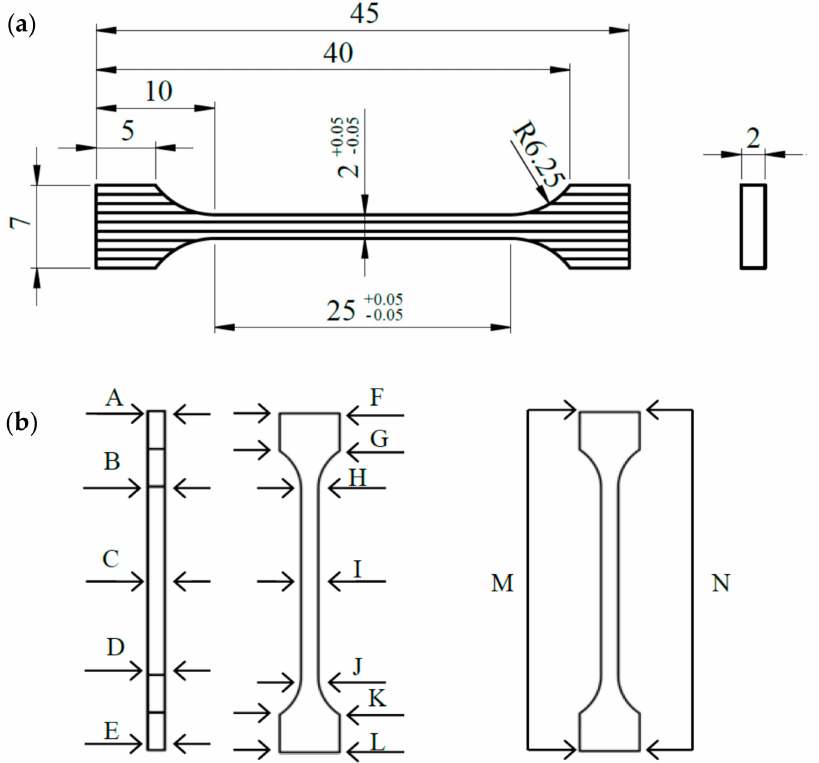
Figure 1. Nominal dimensions of a single sample ( a ) and measurement points ( b ).